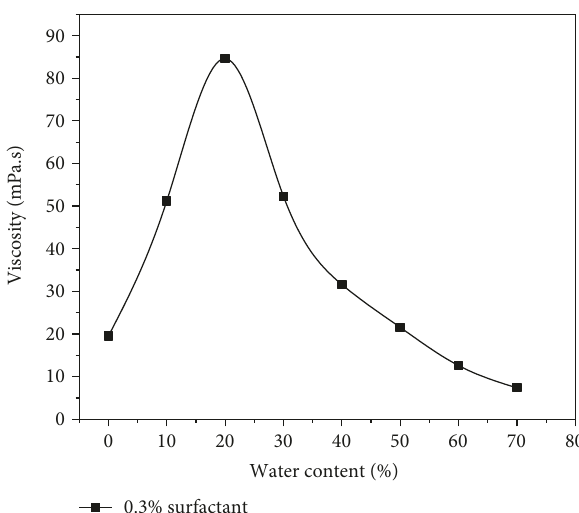
Figure 4: The syneresis rate of emulsion under di ff erent water content.